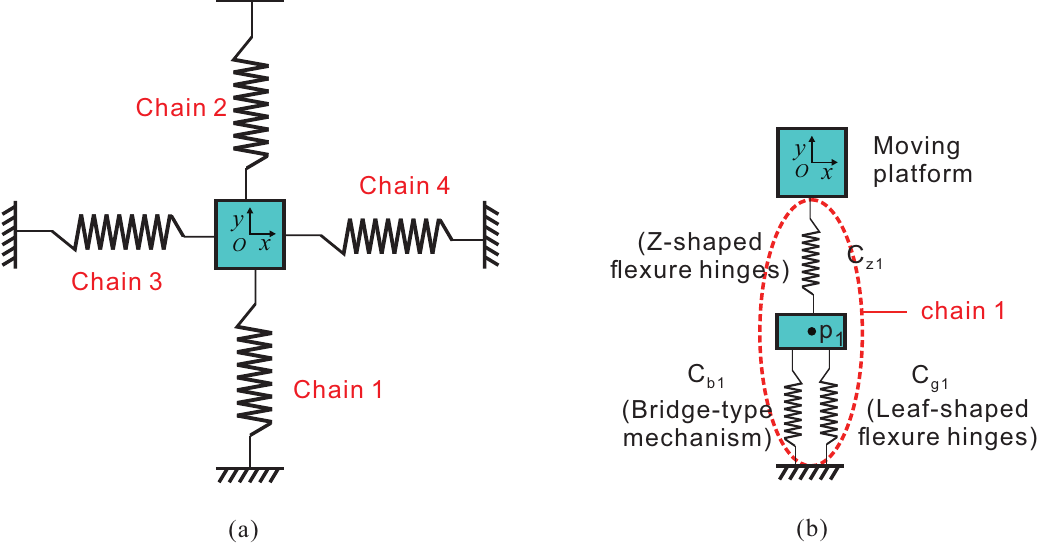
Figure 6. Output compliance model of the platform: ( a ) the total equivalent stiffness model; ( b ) the stiffness model contained in branch chain